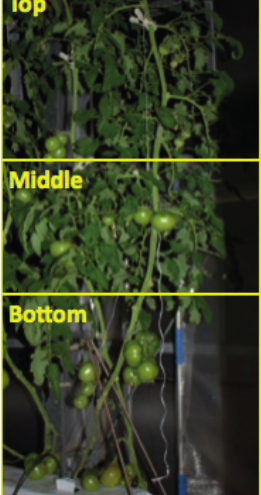
Figure 10. Example of image partition for the part-by-part fruit